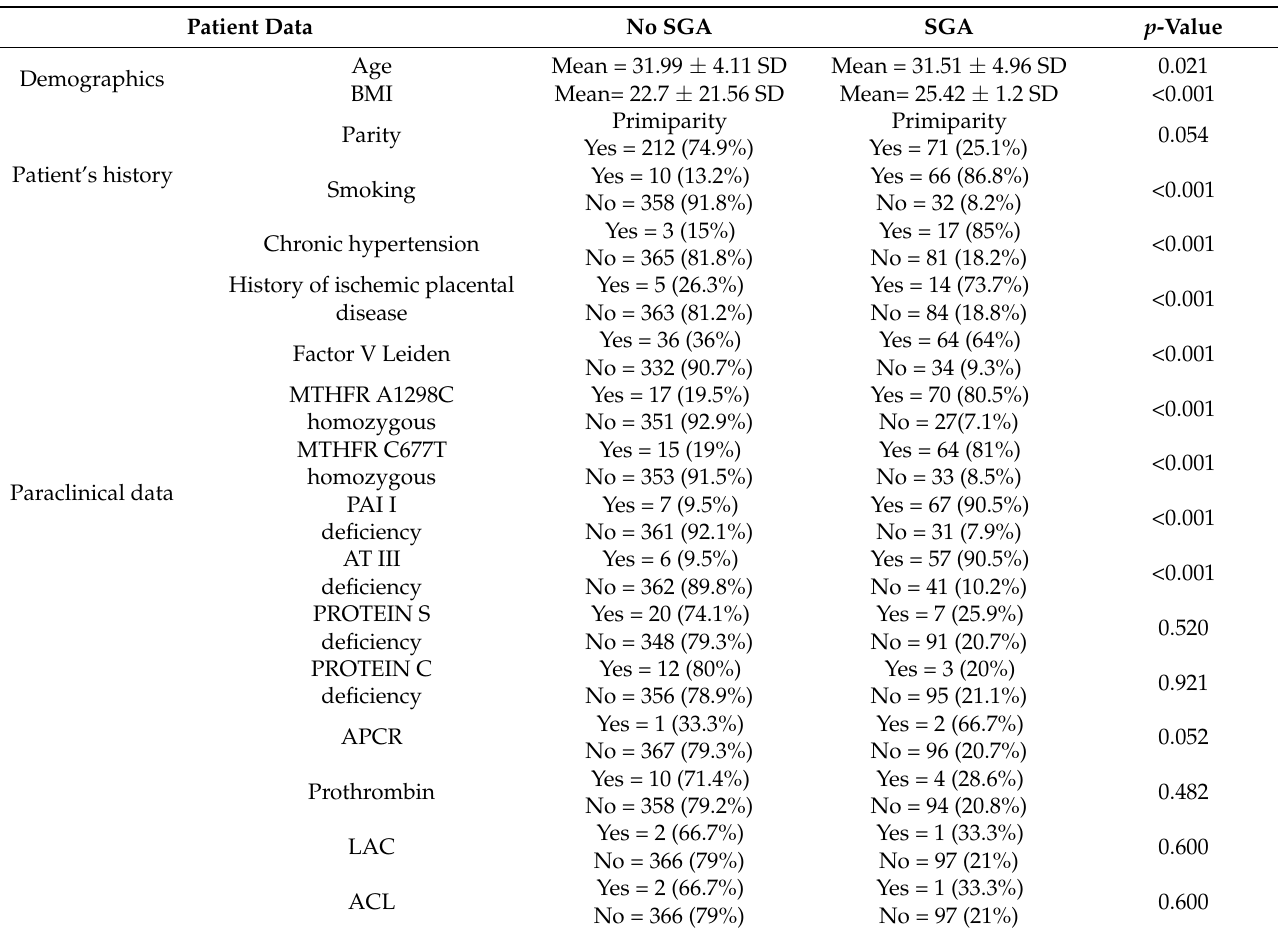
Table 1. Characteristics of pregnant patients with thrombophilia and their association with intrauter- ine growth restriction